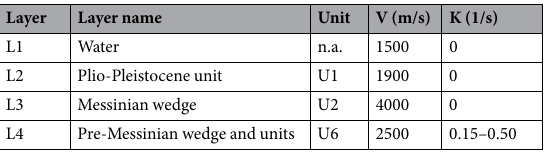
Table 4. Velocity model.